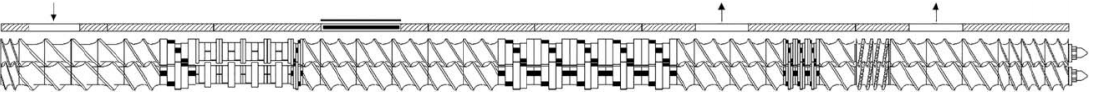
Figure 1. Extruder screw profile configured with distributive and dispersive elements [36].